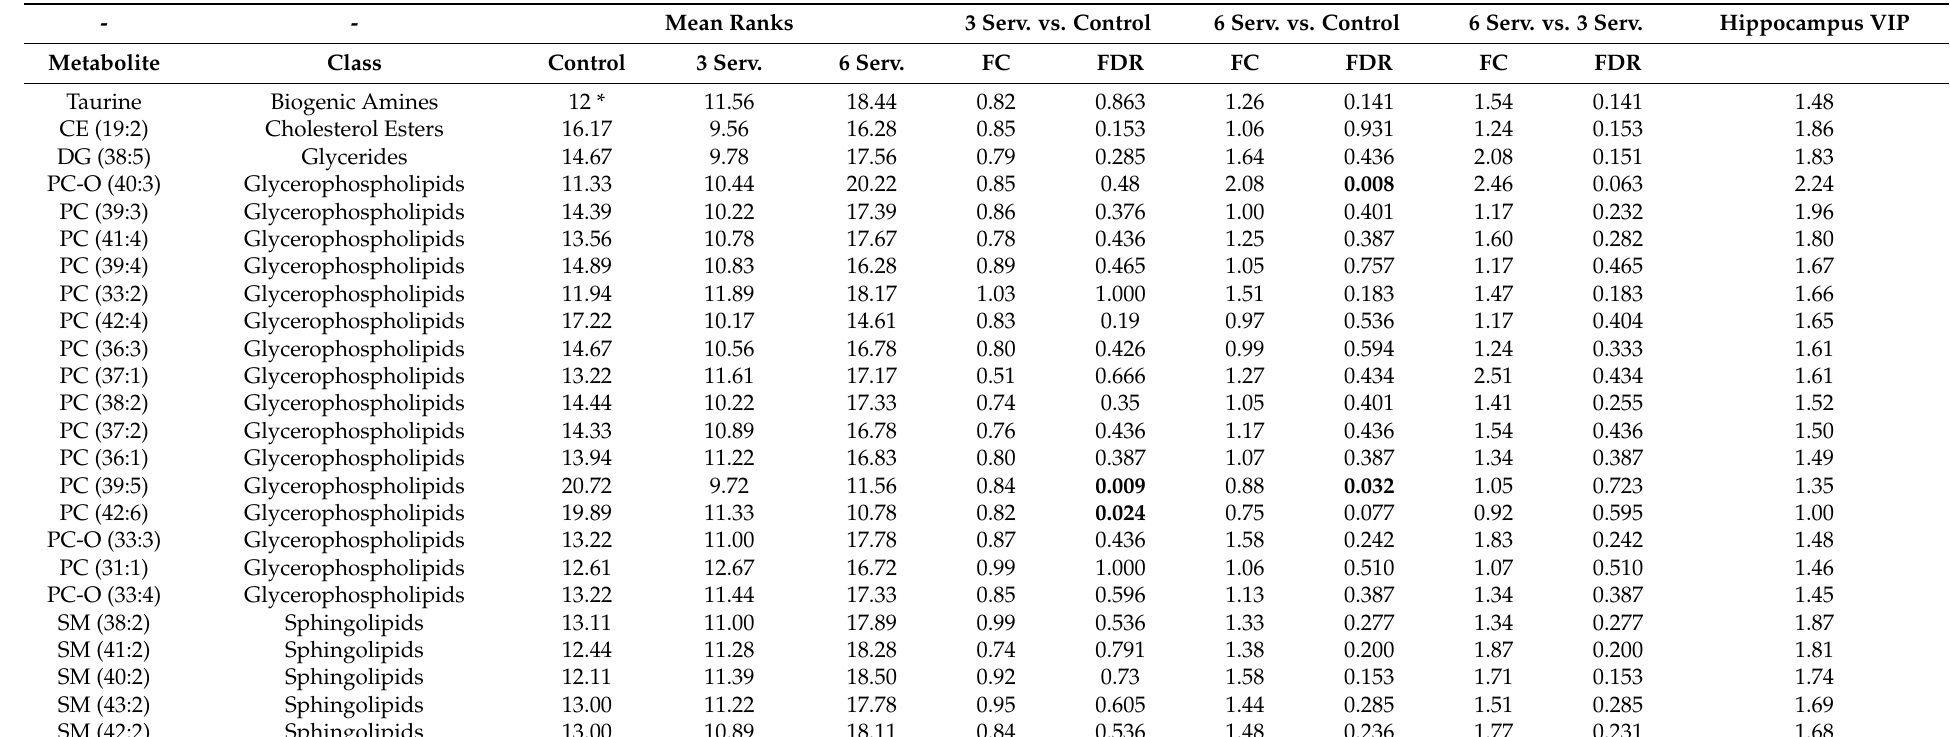
Table 3. Brain Hippocampus metabolites differences among